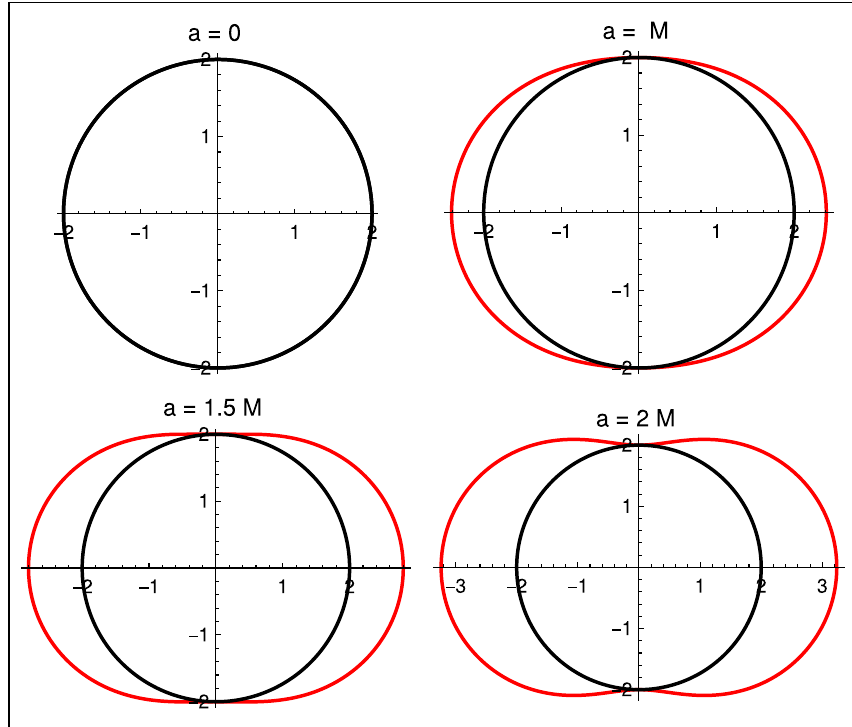
Fig. 1 The event horizon (black curve) and the ergoregion is shown (red outer curve) in a Kerr–Newman-NUT spacetime. Event horizon is always located at r eh = 2 M and it is independent of the angular momentum as well as NUT parameter. The ergoregion is a function of ‘a’ and independent of the NUT parameter ‘ l